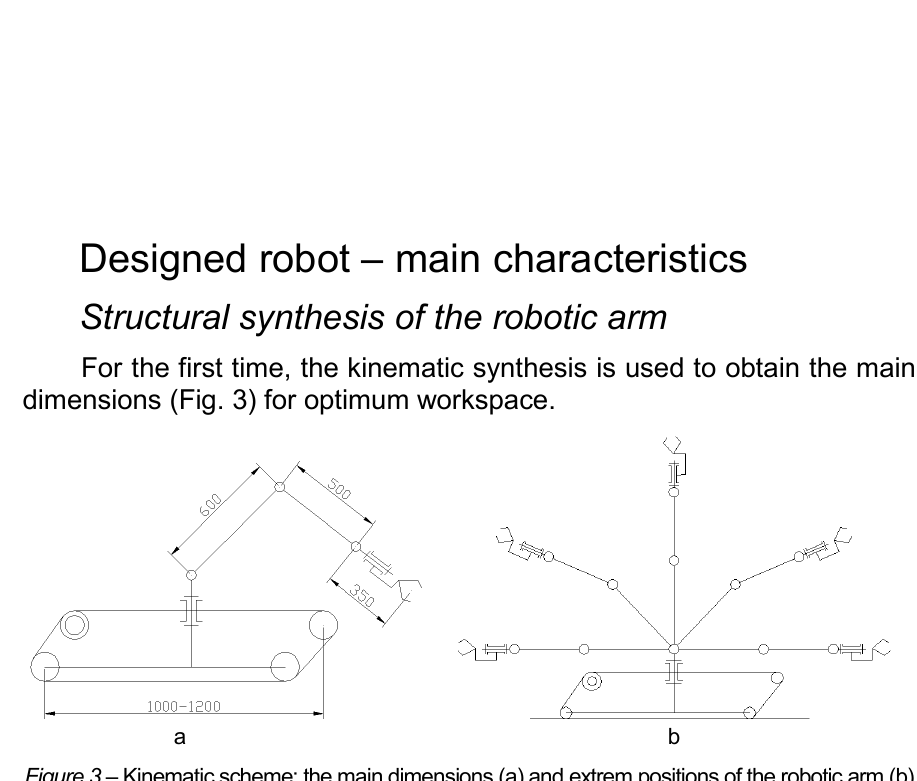
Figure 3 – Kinematic scheme: the main dimensions (a) and extrem positions of the robotic arm (b) Slika 3 – Kinemati č ka šema: glavne dimenzije (a) i krajnji položaji roboti č ke ruke (b)